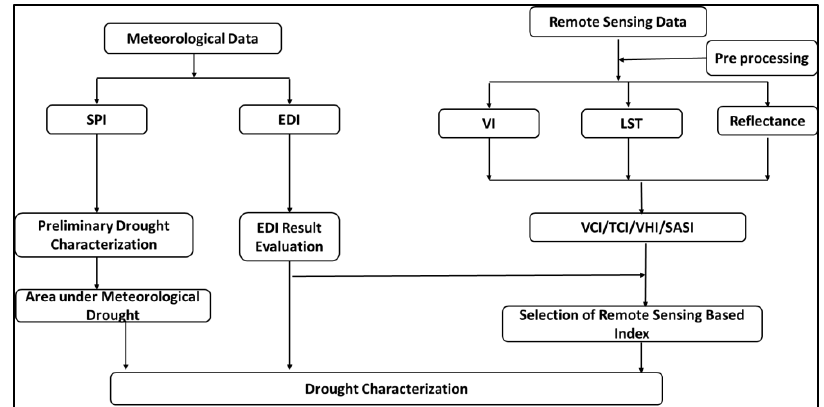
Figure 2. Flowchart of Methodology